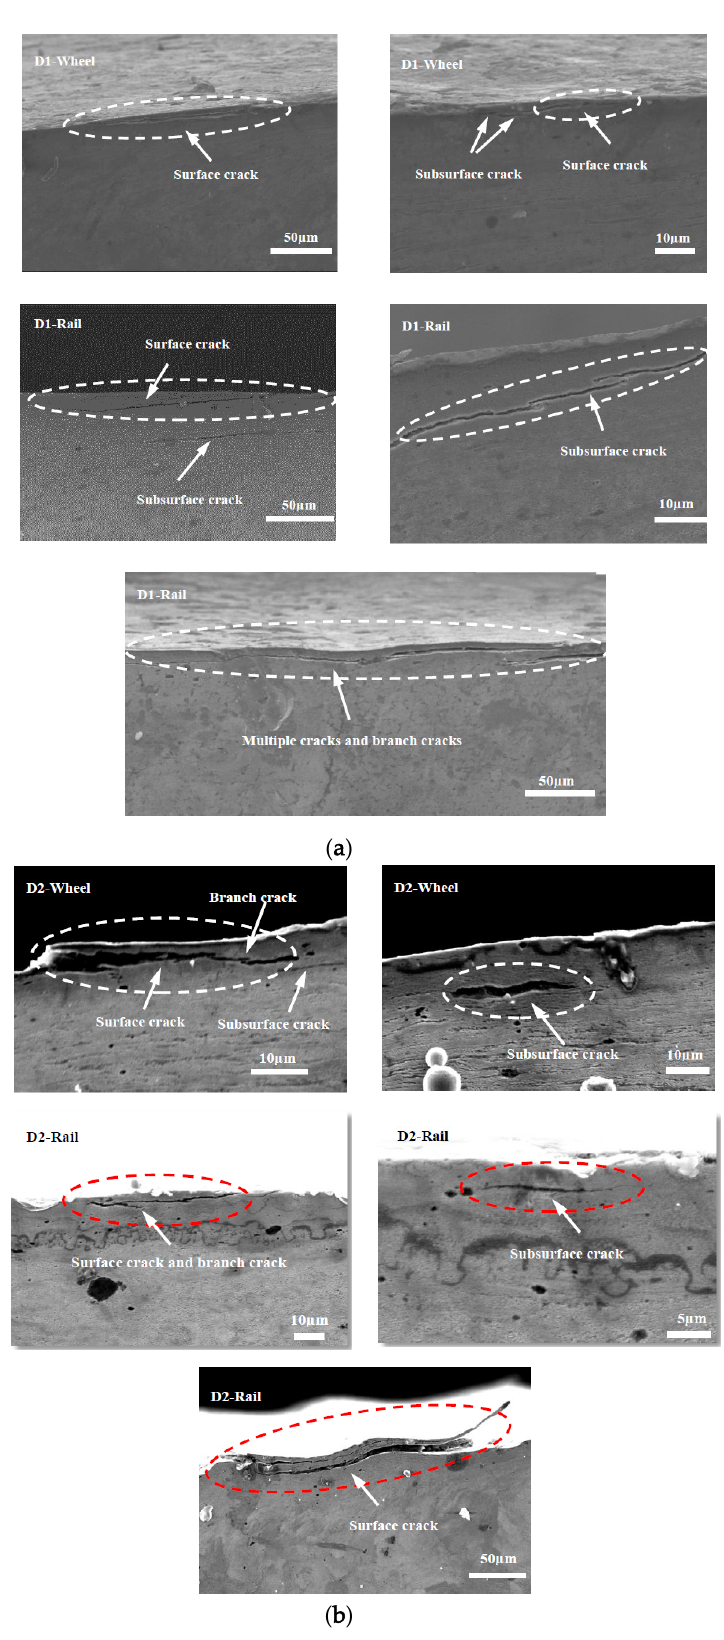
Figure 16. SEM micrographs showing the types of damage of wheel and rail rollers at room temperature. (a) D1; (b) D2.